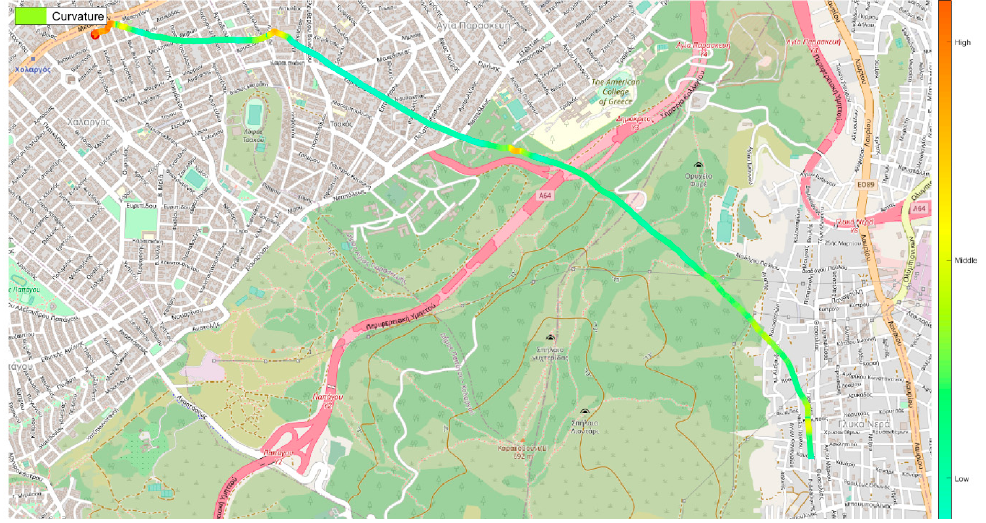
Figure 5. Curvature values on the mouse trajectory. Green values generated during visual search on experimental stimulus.